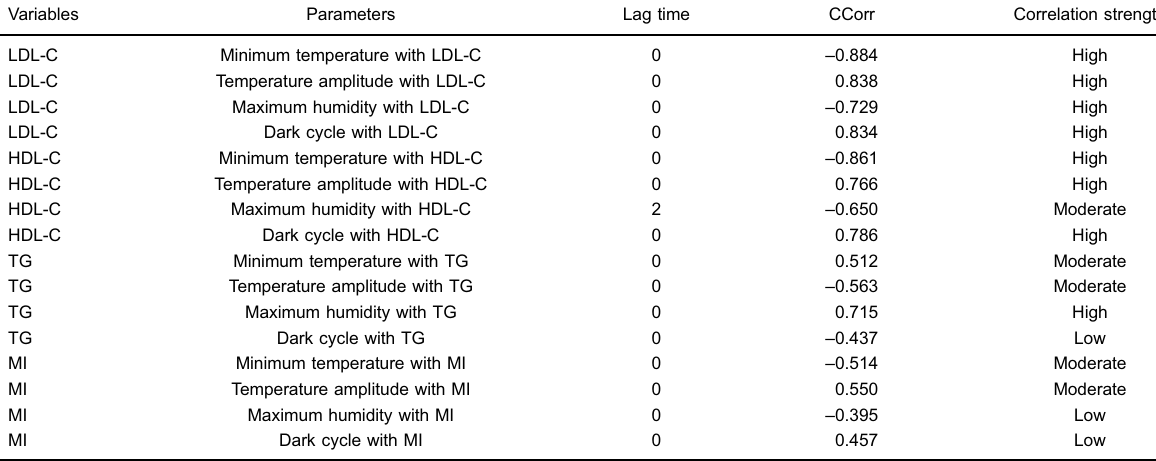
Table 1. Cross-correlation functions of minimum temperature, temperature amplitude, maximum humidity, and dark cycles variability with rhythmicity of LDL-C, HDL-C, TG, and